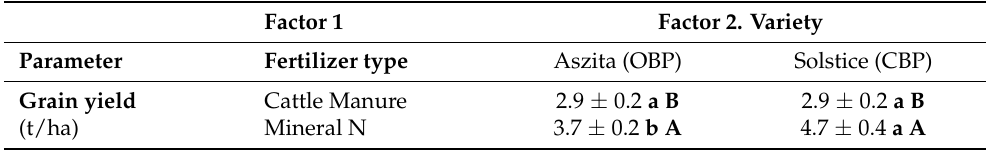
Table 3. Interaction means ± SE for the effects of fertilizer type and variety on grain yield in two winter wheat ( T. aestivum ) field trials carried out at Nafferton Farm, Northumberland, UK.